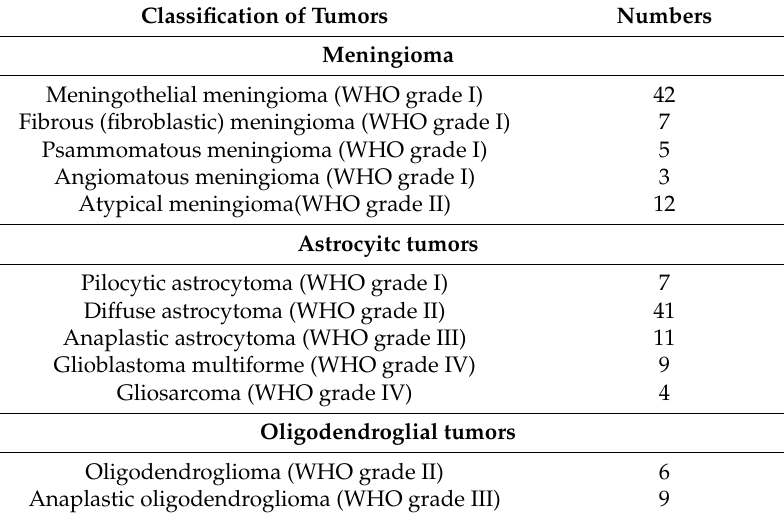
Table 1. The classification of brain tumors and World Health Organization (WHO) grading of 178 cases.